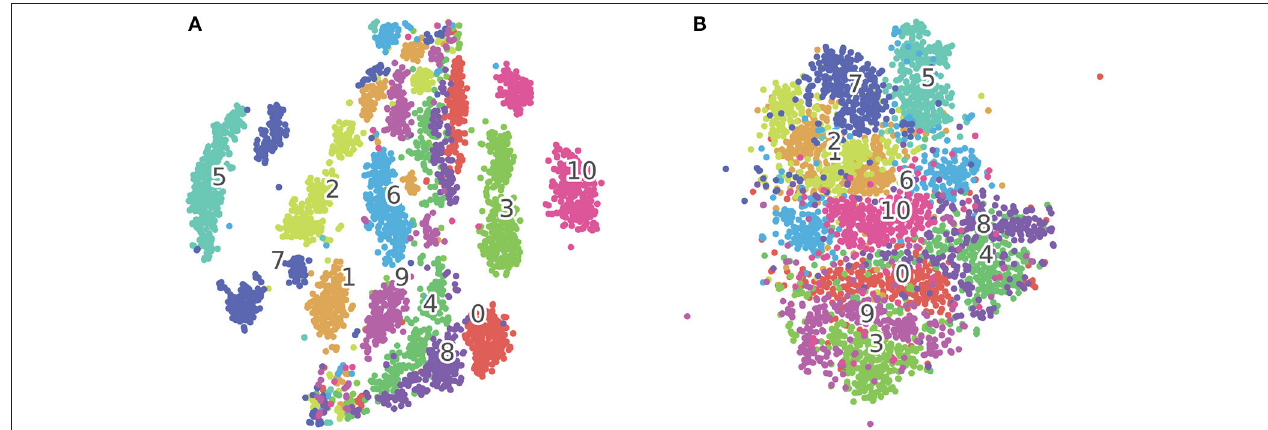
FIGURE 5 | (A) tSNE clustering for concatenated input vectors entering the SOM. (B) tSNE clustering for BMU trajectories output from the SOM. Each dot on the figure corresponds to one test sample in the TIDIGITS dataset, the numbers in the figure correspond to class centroids. The samples (e.g., Class 7 and 10) within the same class get closer after being processed by the SOM as shown in this 2D visualization.